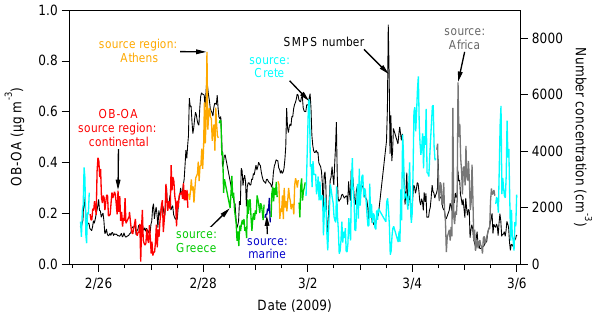
Fig. 10. Zoom of OB-OA time series (left vertical axis) colored by the source region categorized as explained in the text. SMPS num- ber concentrations (right vertical axis) do not correlate with OB-OA